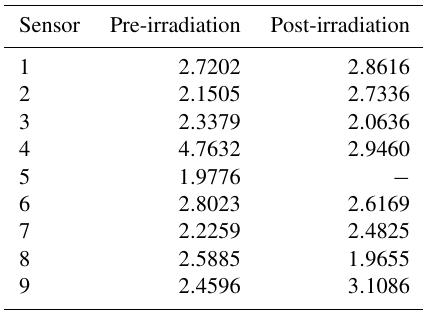
Table 1. Noise floor ( nT/